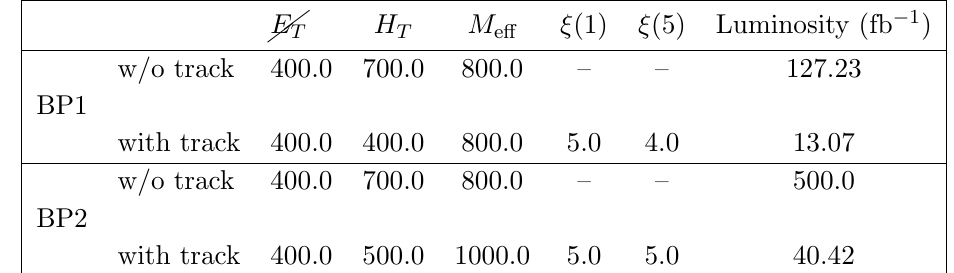
Table 5 . Luminosity required to achieve 5 (cid:27) signi(cid:12)cance for the cut based analysis (with and without tracks) for MUED benchmarks. (cid:26)(cid:26) E T , H T , M e(cid:11) are expressed in units of GeV.